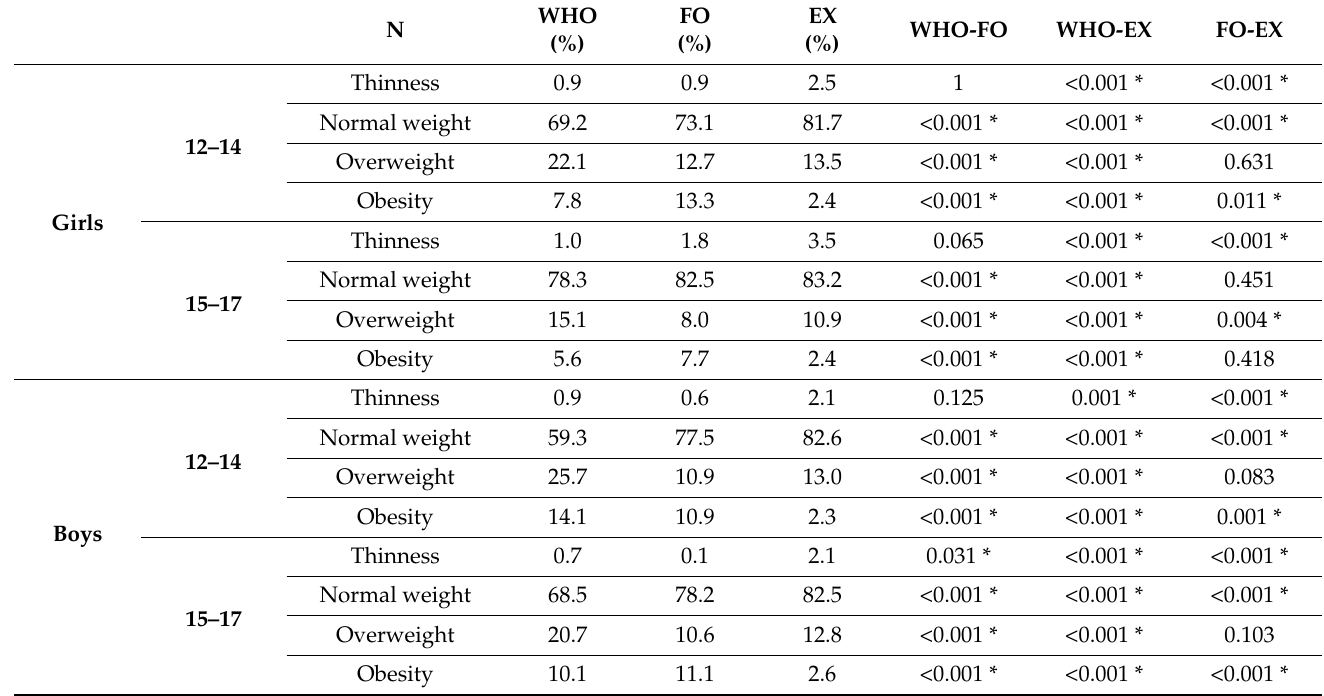
Table 5. Prevalence of different bodyweight categories based on thee WHO, FO, and EX by sex and age range and pairwise comparison between